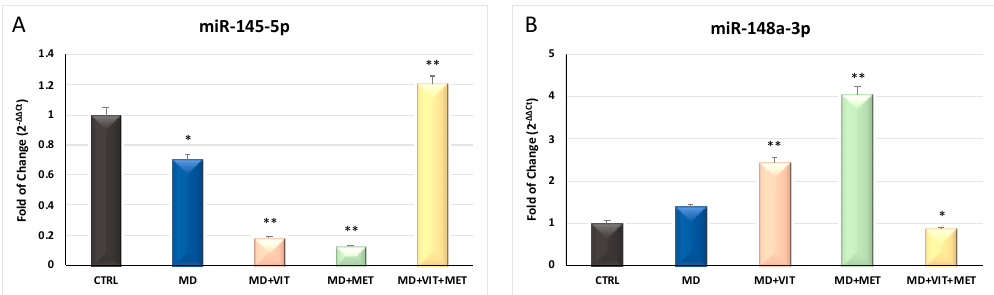
Figure 4. Expression of miRNAs after 21 days of culturing. The expression of miR-145 (Panel ( A )) and miR-148a (Panel ( B )) was evaluated in ADSCs cultured in: growing medium (MG), adipogenic differentiation medium (MD) (blue bars), or in MD in the presence of vitamin D (orange bars), or in MD in the presence of metformin (green bars), or in MD with metformin plus vitamin D (yellow bars). The mRNA levels for each gene were normalized to U6snRNA and expressed as fold of change (2 −∆∆ Ct ) of the mRNA levels observed in undifferentiated control ADSCs (black bars) defined as 1 (mean ±SD; n = 6). Data are expressed as mean ± SD referred to the control (* p ≤ 0.05; ** p ≤ 0.01).